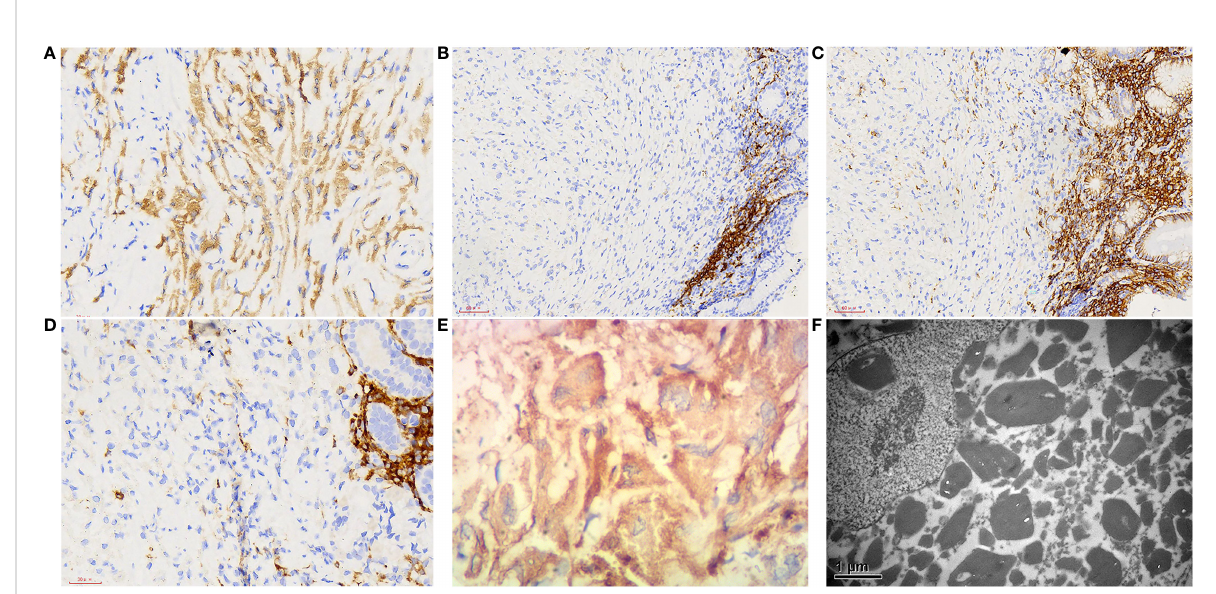
FIGURE 2 Immunophenotype and electron microscopic manifestations of gastroscopy biopsy tissue. (A) CD68, 400×; (B) CD20, 400×; (C) CD138, 400×; (D) CD79a, 400×; (E) kappa light chain, 400×; (F) Electron microscopic examination showed that a large number of high electron density particles were found in the cytoplasm of cells, with crystal structures with different sizes and shapes,